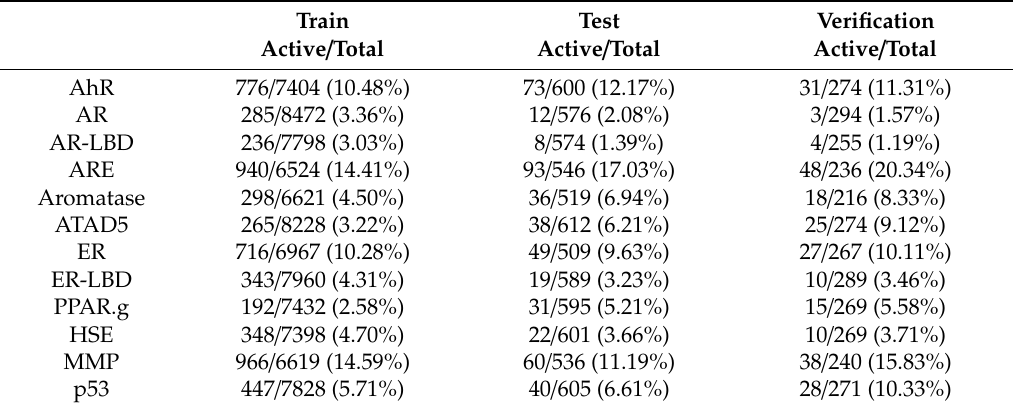
Table 3. Data distribution. The table shows the size of the training data set and test data set for each property, as well as the distribution of validation data set for each